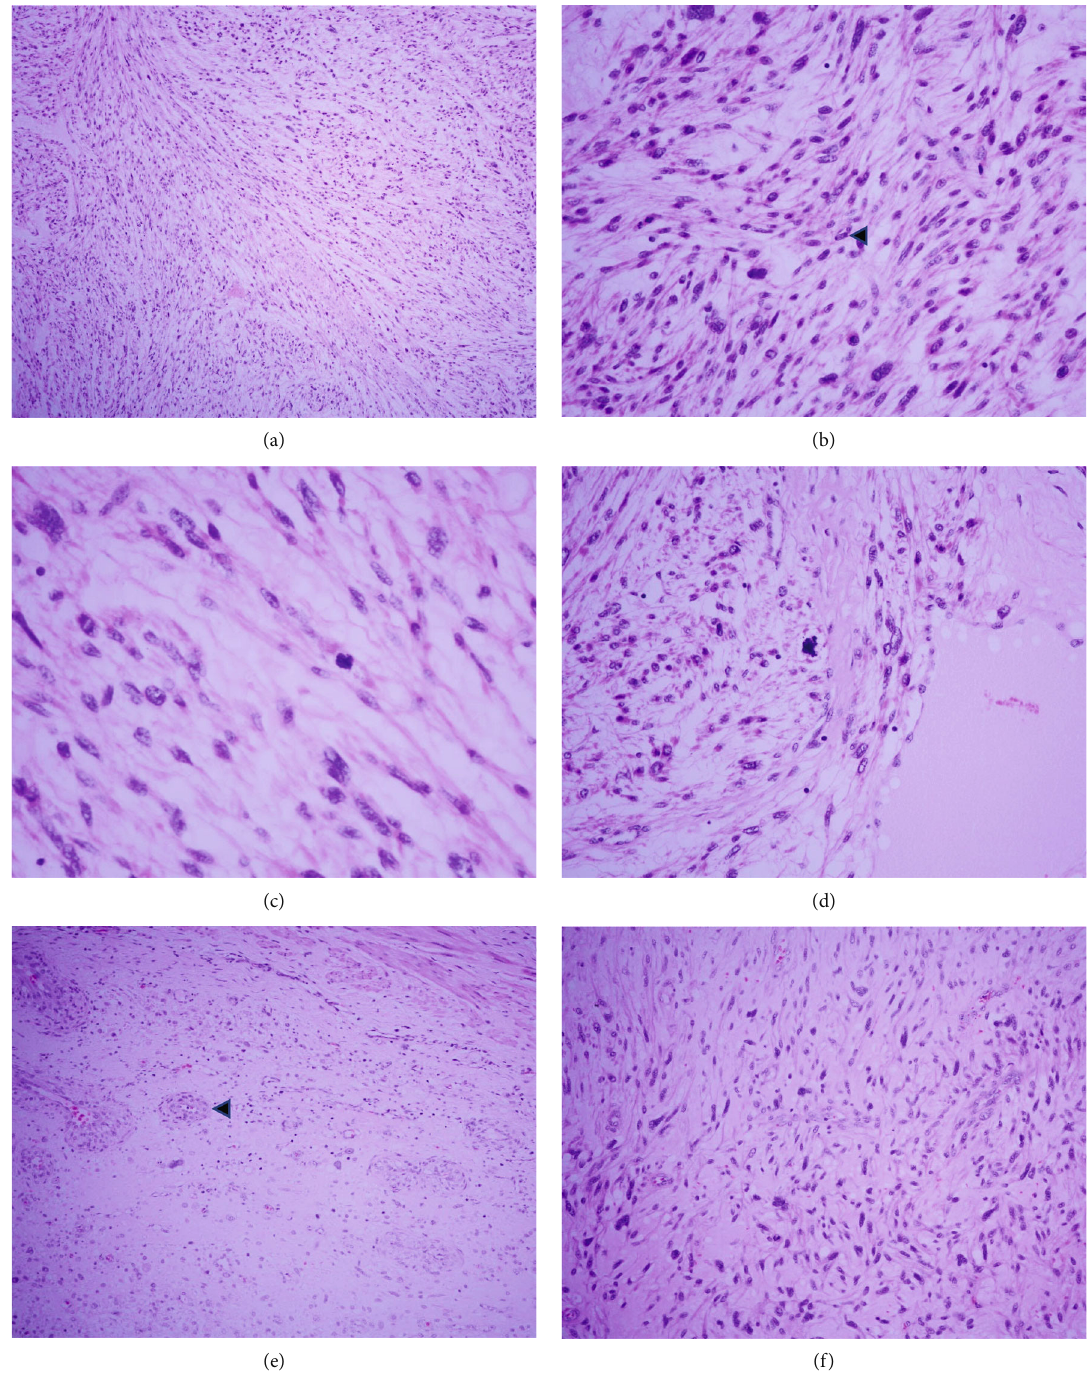
Figure 6: (a) Low power magni fi cation of leiomyosarcoma reveals typically intersecting 90-degree angle fascicular arrangement of spindle cells. (b) High magni fi cation area shows scattered pleomorphic hyperchromatic cells with typically “ cigar-shaped ” nuclei (arrowhead) and eosinophilic cytoplasm. (c) and (d) Reveals increase mitotic activity with atypical forms. (e) and (f) Sections from the main vessel show the neoplasm derived from the tunica media of the vessel (arrowhead) and high magni fi cation reveals signi fi cantly cytologic